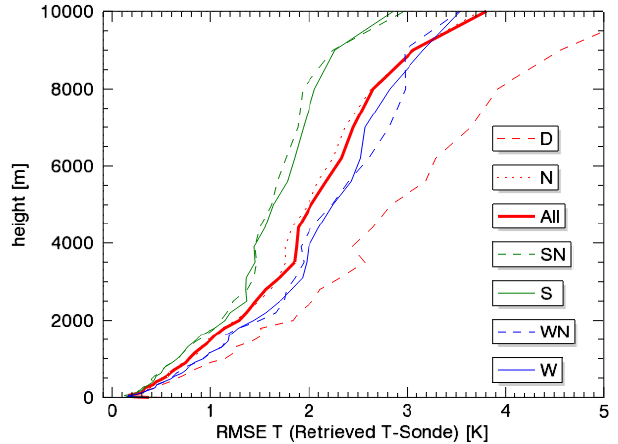
Figure 9. Comparison between a retrieval based only on the bright- ness temperatures (called “no additional regr.”), a retrieval with the temperature at 1600m (called “1 additional regr.”) and a retrieval with the temperature at several heights (400, 800, 1200, 1600m) as further regressors (called “4 additional regr.”). The RMSE is be- tween retrieved temperature and radiosonde in function of height (above